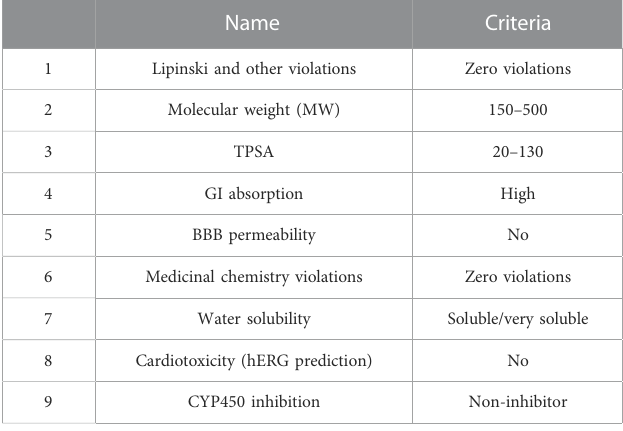
TABLE 1 Inclusion/exclusion criteria for shortlisting of the compounds.